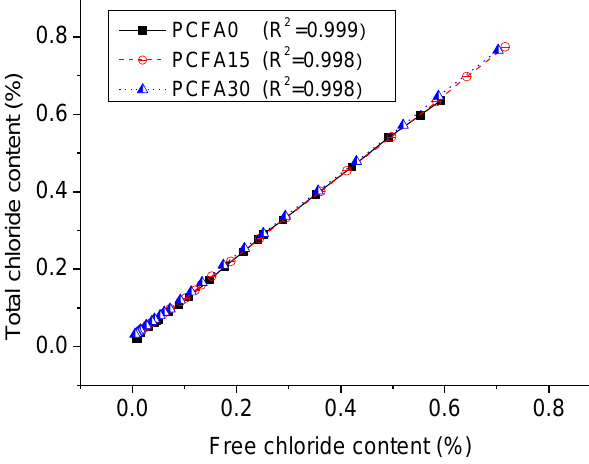
Figure 7. Relation between free chloride and total chloride depth (by mass%).